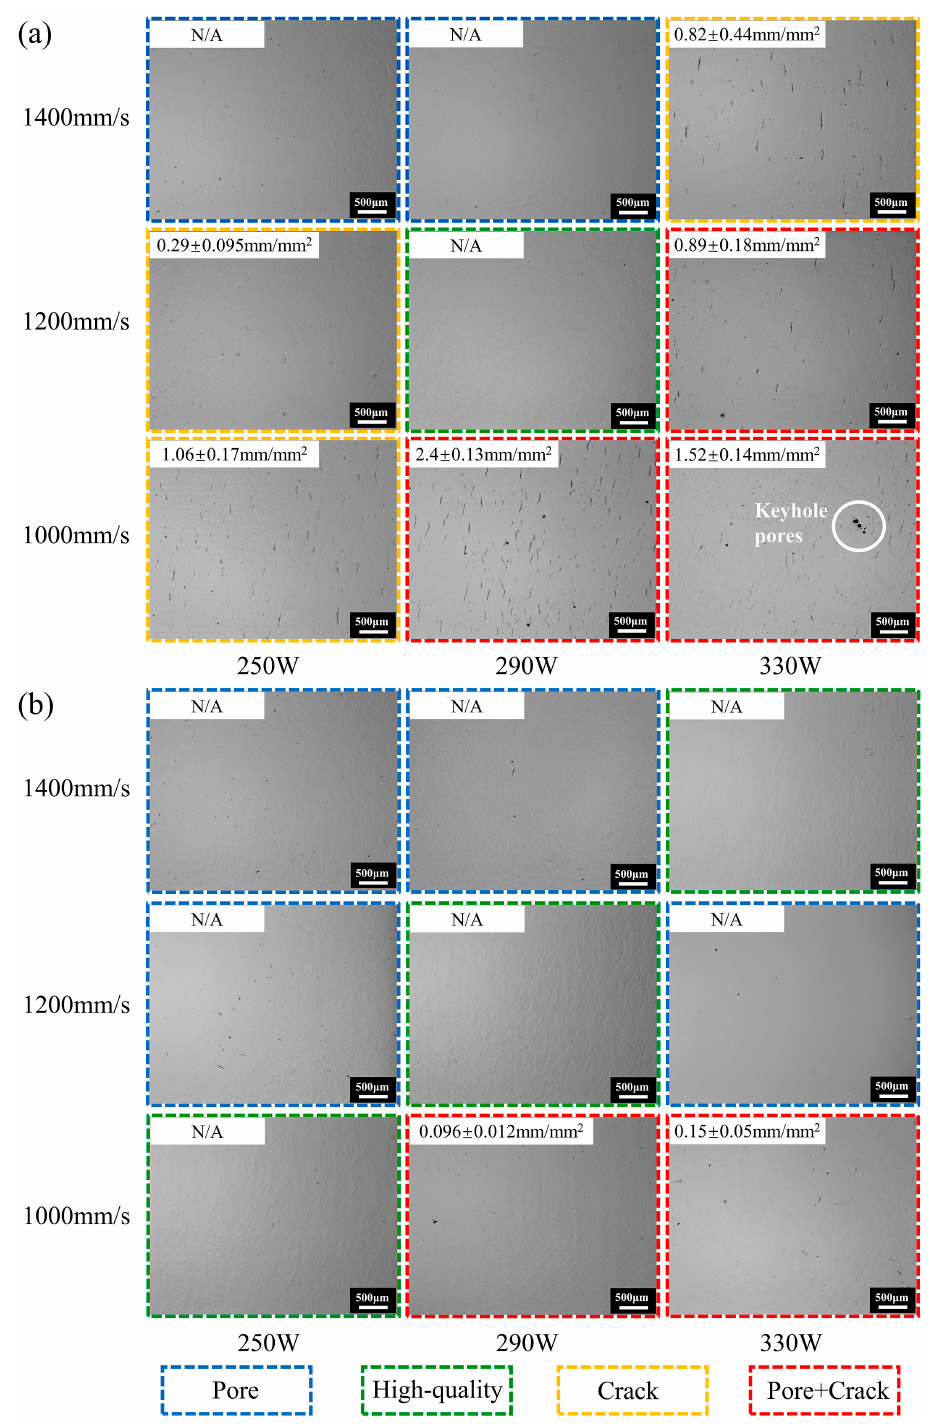
Figure 7. OM images of the polished surfaces of Inconel 738 alloy ( a ) without Y 2 O 3 and ( b ) with Y 2 O 3 fabricated by LPBF showing pore and crack under different laser powers and scan speeds as well as the corresponding crack density [57].